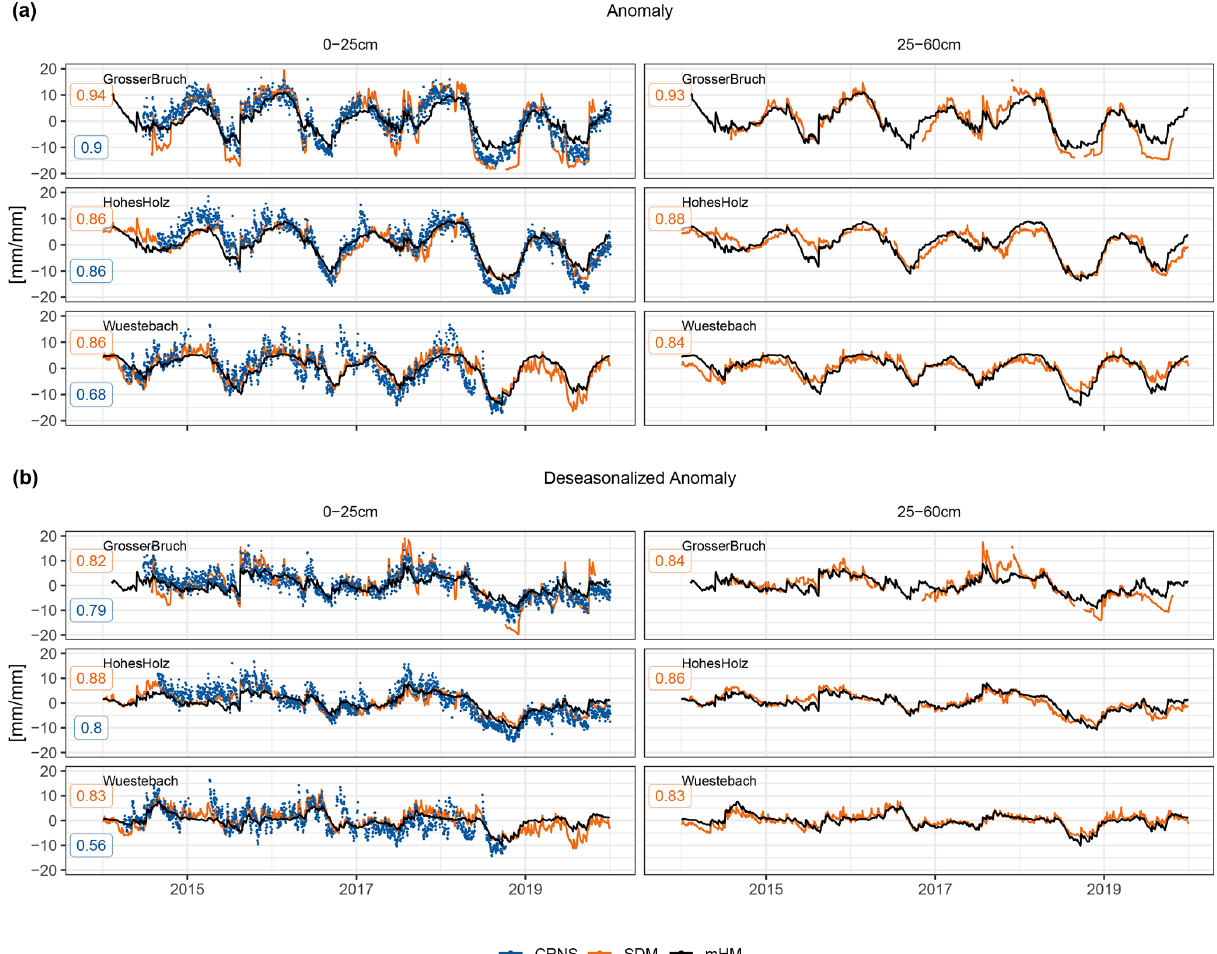
Figure 3. SM time series for 2014–2019 for the selected locations Am Grossen Bruch, Hohes Holz, and Wüstebach, showing SDM and CRNS data against simulated data from mHM in 0–25 and 25–60cm depth in the GDM-v2-2021 setup. The Hordorf site also contains both CRNS and SDM measurements but with much shorter time series length. The stations with longer time series were selected for visualization. Spearman rank correlation coefficients are denoted at the left side of each time series. Panel (a) shows SM anomalies, including seasonality, and panel (b) shows deseasonalized SM